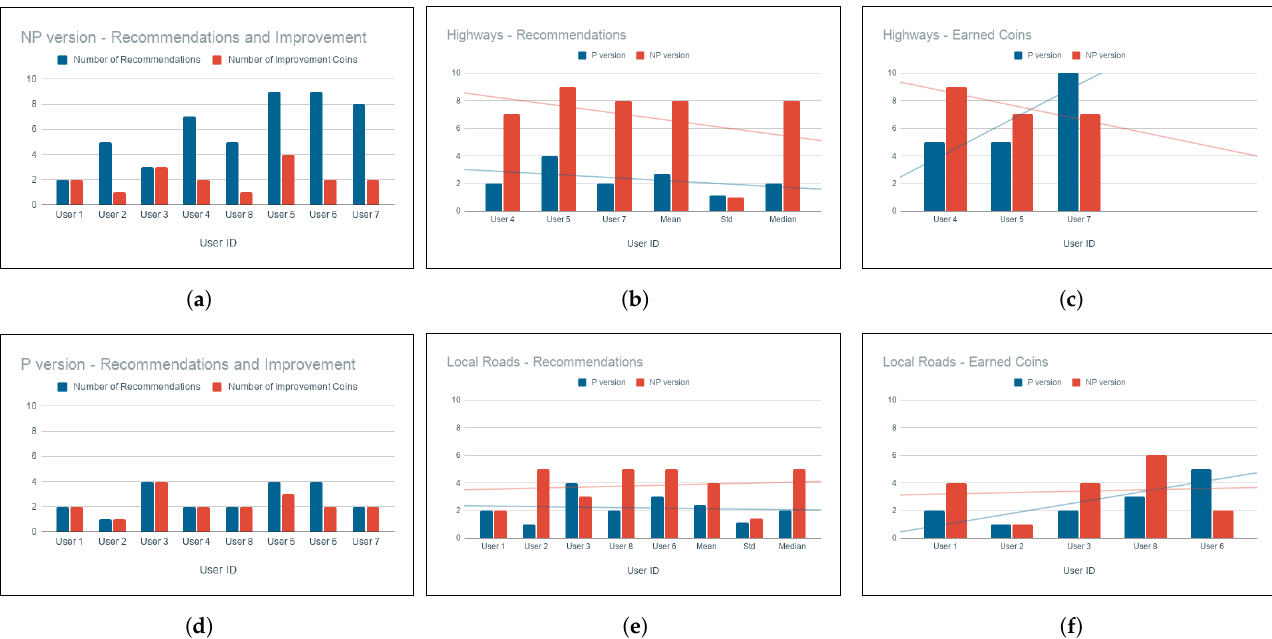
Figure 9. User study statistics. ( a ) Version NP—recommendations vs. improvement coins. ( b ) Highways—recommendations. ( c ) Highways—earned coins. ( d ) Version P—recommendations vs. improvement coins. ( e ) Local roads—recommendations. ( f ) Local roads—earned